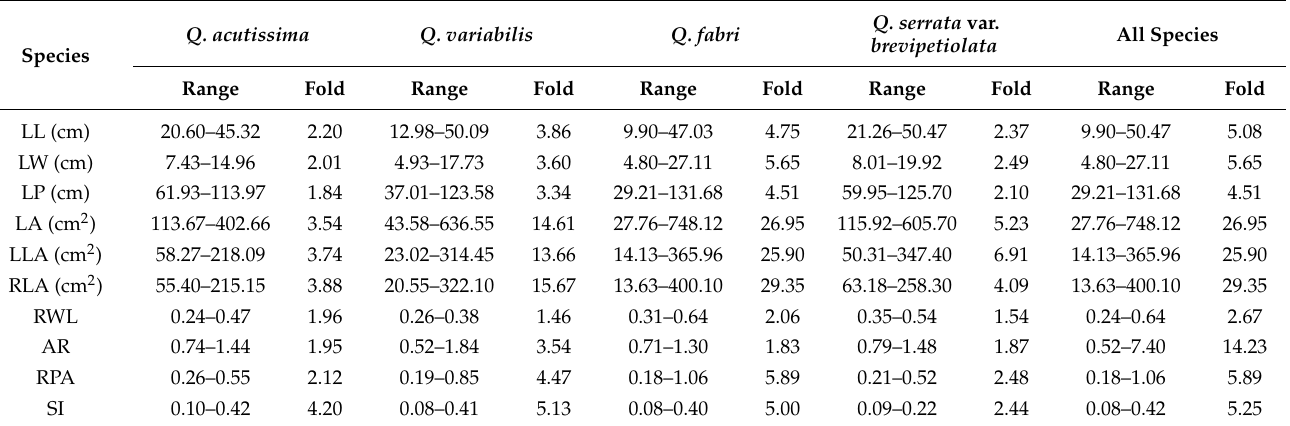
Table 2. Leaf phenotypic variation range of four oak species.